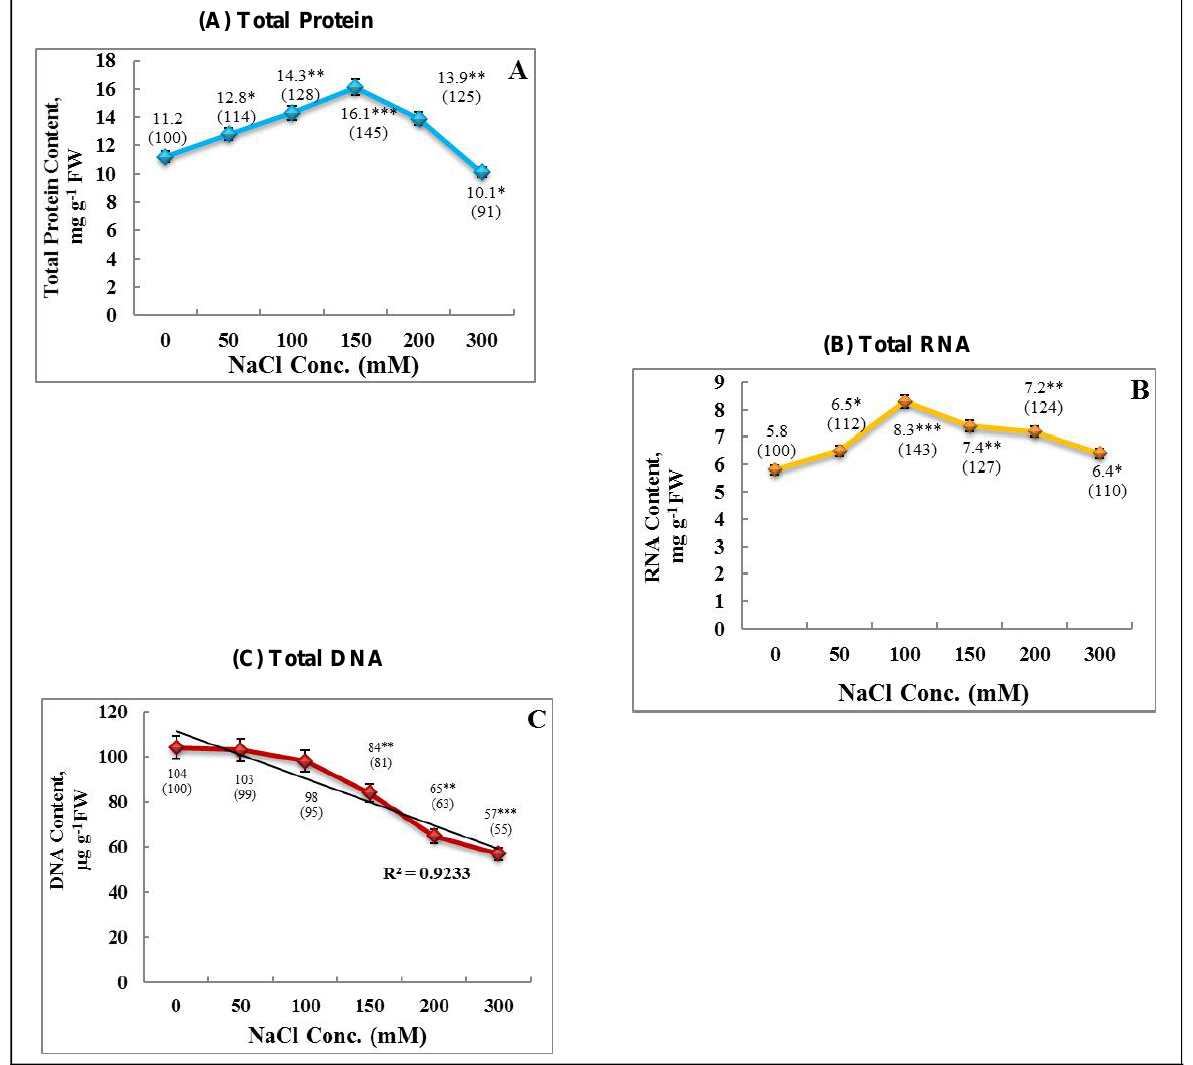
Figure 1: Effect of salt stress imposed by using NaCl on total protein, total RNA and DNA content in etiolated maize leaf segments during